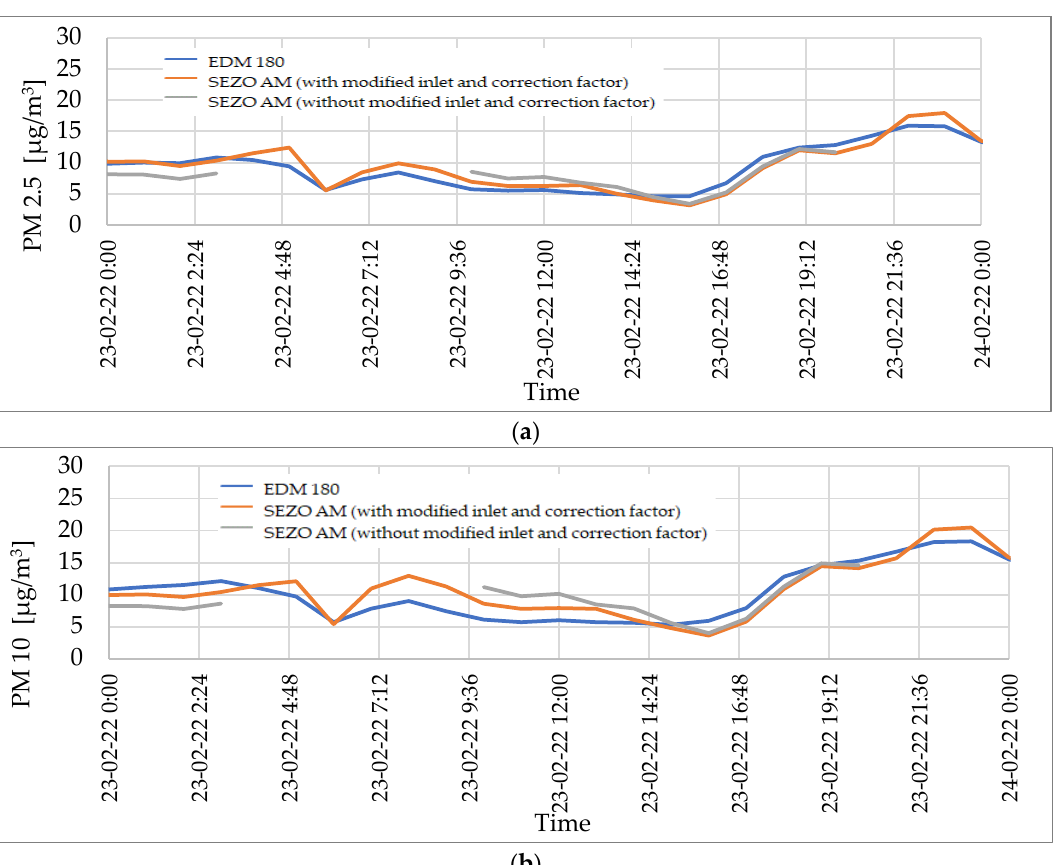
Figure 13. The variability of the hourly concentration values of PM2.5 ( a ) and PM10 ( b ) obtained on 23 February 2022 for EDM 180 analyser, and for two SEZO AM analysers (with and without modified inlet and correction factor).